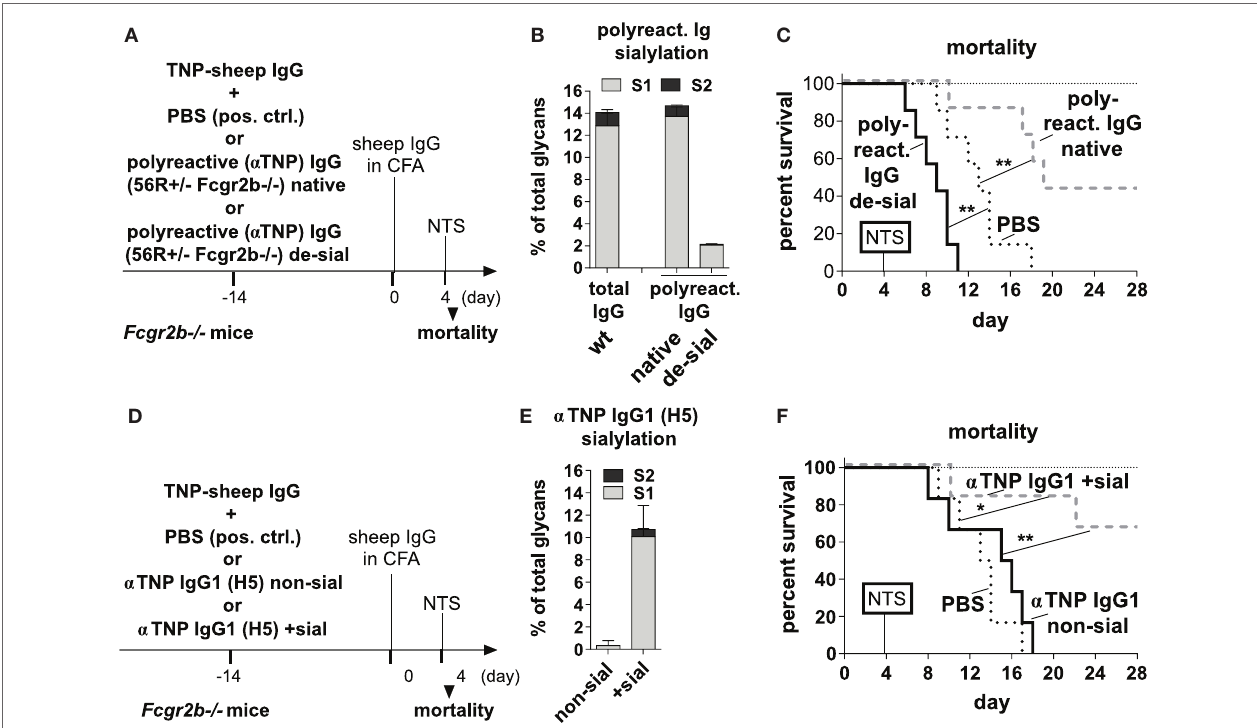
FigUre 4 | Transfer of sialylated polyreactive IgG antibodies (Abs) derived from 56R + / − Fcgr2b − / − mice or administration of sialylated antigen-specific monoclonal IgG Abs reduces nephritis-induced mortality in Fcgr2b − / − mice. (a–c) Transfer of sialylated polyreactive IgG Abs from 56R + / − Fcgr2b − / − mice reduces nephritis-induced mortality. (a) Graphical representation of the experimental strategy. Fcgr2b − / − mice received ICs containing 100 µg of TNP-sheep IgG and 200 µg of either sialylated (native) or sialidase-treated de-sialylated (de-sial) polyreactive IgG Abs derived from 2–3-month-old 56R + / − Fcgr2b − / − mice. The positive control (pos. ctrl.) group was treated with PBS and TNP-sheep IgG only. After 14 days, nephritis was induced by injection of sheep IgG in CFA and subsequent intravenous injection of sheep anti-glomerular basement membrane nephrotoxic serum (NTS) 4 days later. (B) Fc sialylation of purified total serum IgG Abs from wt mice and purified polyreactive IgG Abs from 56R + / − Fcgr2b − / − mice before and after sialidase treatment was determined through EndoS-treatment and MALDI-TOF mass spectrometry (MS) (percentage of glycans with one or two sialic acid residues: S1 and S2; Figure S1 in Supplementary Material). (c) Kaplan-Meier survival analysis of the indicated groups. (D–F) Application of sialylated antigen-specific monoclonal IgG Abs reduces nephritis-induced mortality. (D) Graphical representation of the experimental strategy as described in (a) . Fcgr2b − / − mice were treated with ICs containing 100 µg of TNP-sheep IgG and 100 µg of either native non-sialylated ( α TNP murine IgG1 non-sial) or in vitro sialylated ( α TNP IgG1 +sial) monoclonal anti-TNP murine IgG1 (clone H5) Abs. After 14 days, nephritis was induced as described above. (e) Fc sialylation of the monoclonal anti-TNP murine IgG 1 Abs (clone H5) before and after in vitro sialylation was determined through EndoS-treatment and MALDI-TOF MS (the percentage of one or two sialic acid residues coupled to the glycan: S1, S2; Figure S1 in Supplementary Material). (F) Kaplan–Meier survival analysis for the indicated groups. One representative experiment out of two independent experiments is